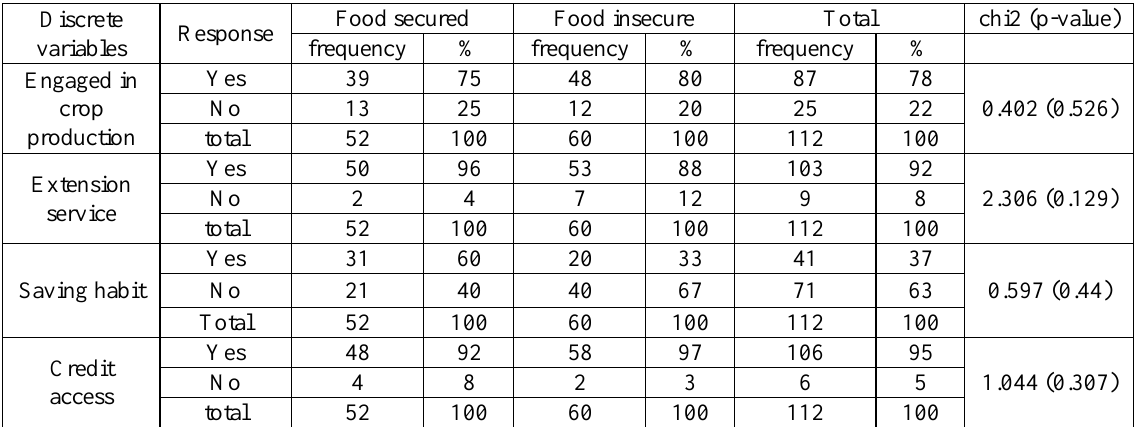
for the discrete variables